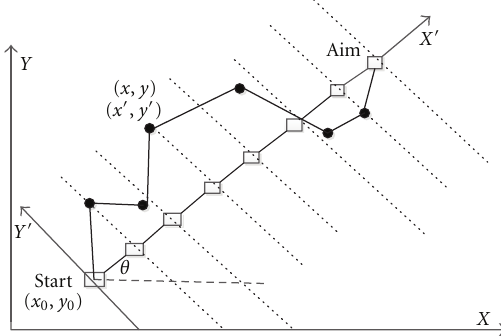
Figure 1: Coordinates transformation